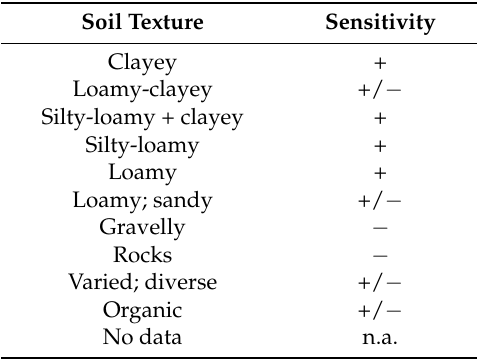
Table 2. Risk of soil disturbance from machine traffic according to soil texture, adapted from Wiebel [49], where “ − “ indicates that soils are insensitive to traffic; “+” indicates that soils are sensitive to traffic; and “+/ − “indicates that soils are partly sensitive to traffic.